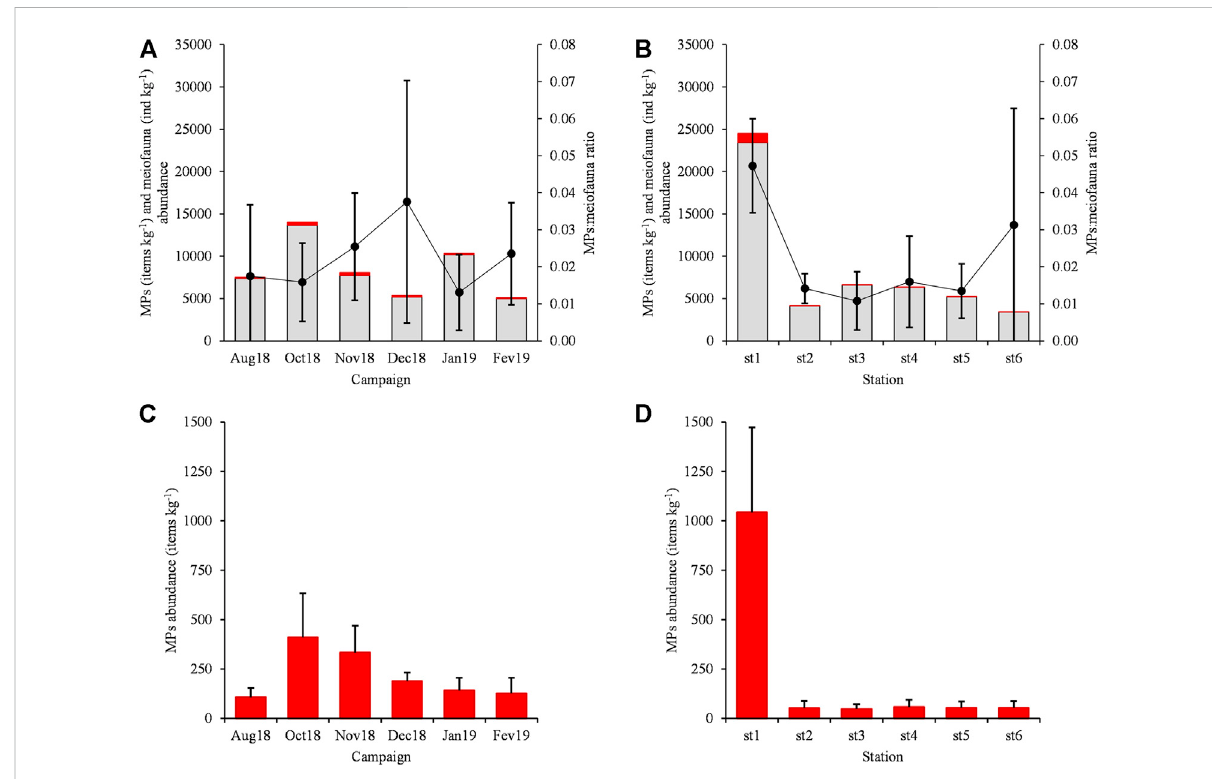
FIGURE 5 MPs abundance (items kg − 1 ) (red bar), meiofauna abundance (individuals kg − 1 ) (grey bar) and MPs to meiofauna ratio (black dots), per campaign (A) and per station (B) . MPs abundance (items kg − 1 ; mean ± SD; n = 6) per campaign (C) and per station (D)